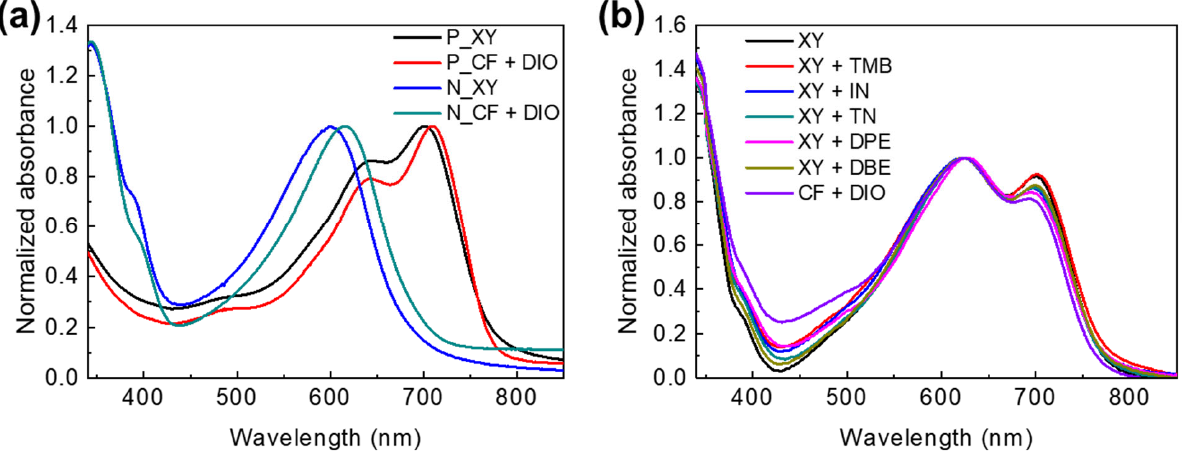
Figure 3. UV − visible absorption spectra of ( a ) PTB7 ‐ Th (P) and PNDI2HD ‐ T (N) polymer films processed from XY only and CF + DIO solutions and ( b ) polymer blend films processed from XY, XY + additive, and CF + DIO solutions.